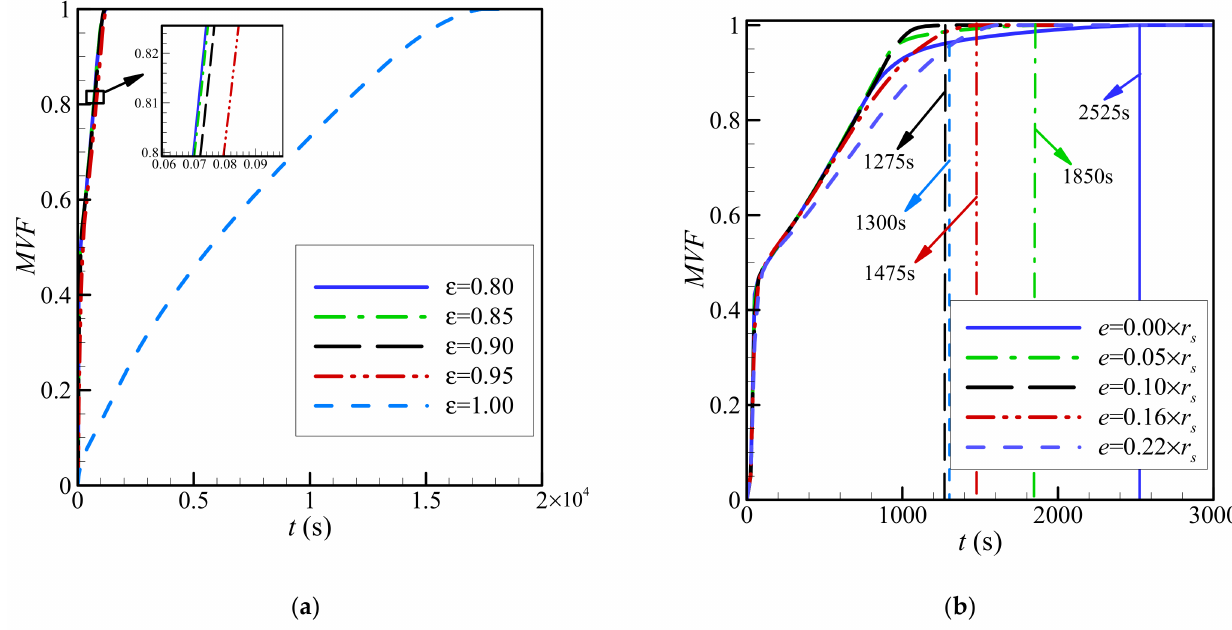
Figure 11. The effects of porosity (with an eccentricity e of 0.12 r s and a nanoparticle volume fraction σ of 0.04) ( a ) and eccentricity (with a porosity ε of 0.8 and a nanoparticle volume fraction σ of 0.04) ( b ) on the MVF for copper nanoparticles as